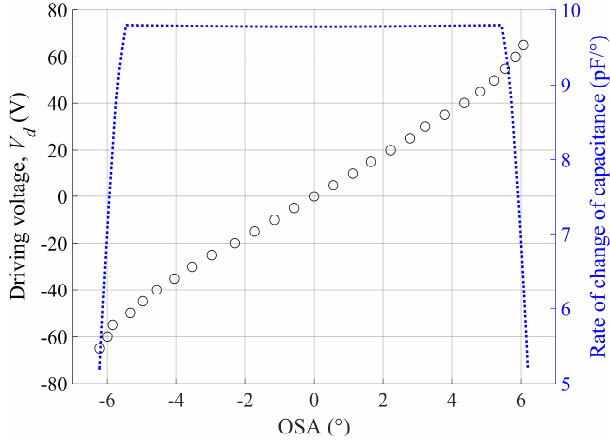
Figure 3. Nonlinear characteristics of the microscanner in quasistatic mode under the condition of V-linearization (open circles: experimental OSA; dotted line: calculated rate of change of capacitance).